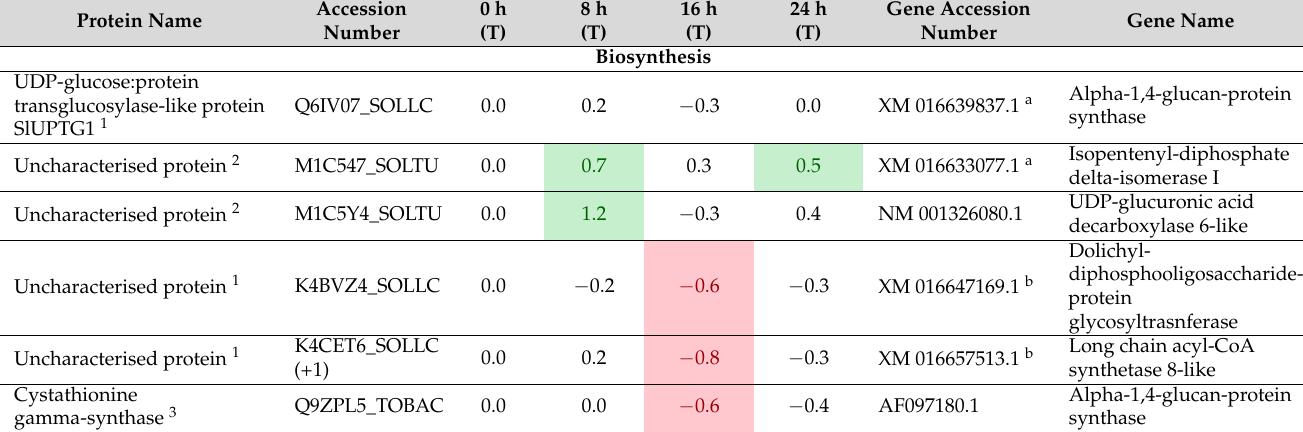
Figure 2. Functional classification of INAP-responsive proteins identified through iTRAQ. The chart represents proteins identified from N. tabacum cell suspensions across the time study of 0–24 h, expressed as percentages, and determined in relation to the reference/control (0 h). Functional category terms were obtained from Uniprot and confirmed following TBLASTN and the available literature [8]. Table 1. Processed data of the differentially regulated proteins of abundance observed in the INAP- treated N. tabacum cells